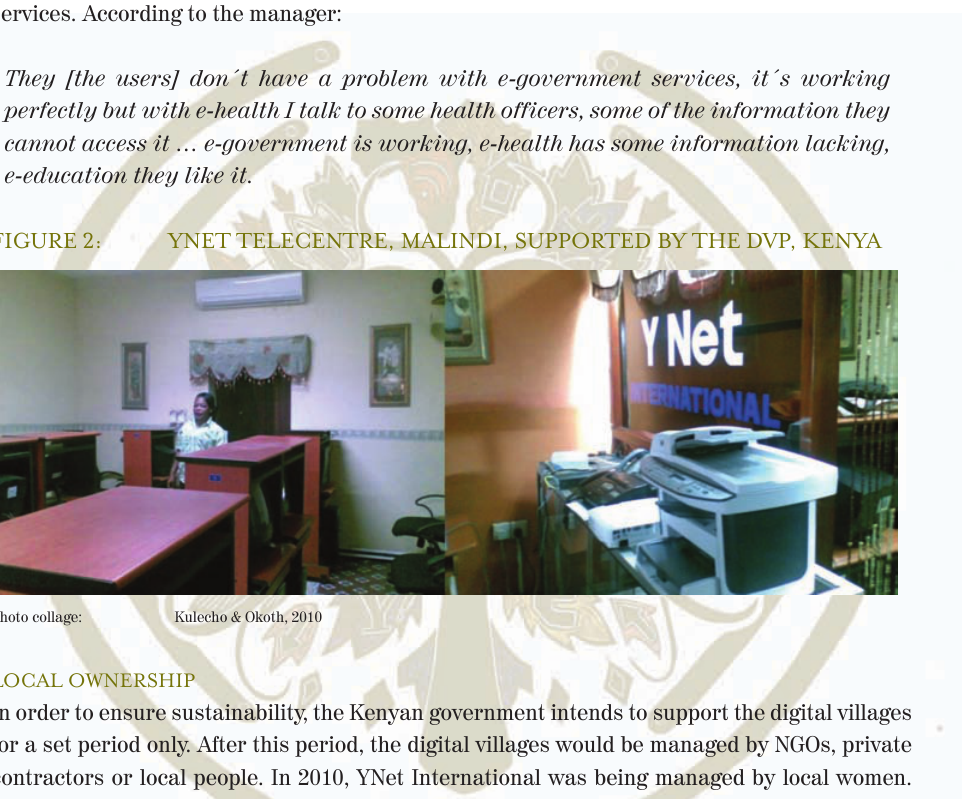
YNET TELECENTRE, MALINDI, SUPPORTED BY THE DVP,